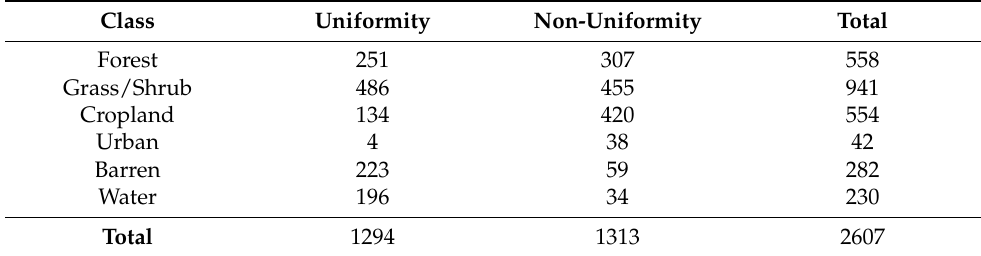
Table 8. Spatial uniformity of 990 m scale for DCP validation